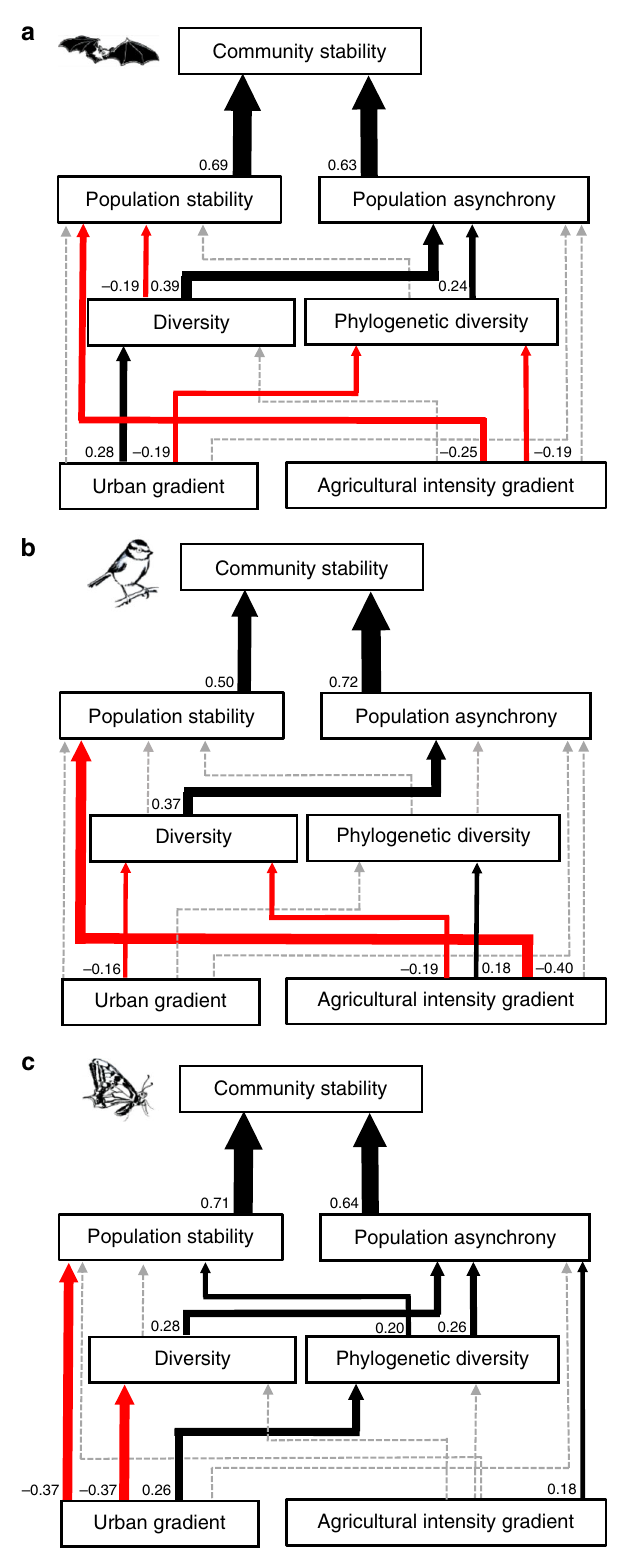
Fig. 4 Effects of habitat degradation and local diversity on community stability estimated by structural equation models. Panels refer to bat ( a ), bird ( b ), and butter fl y ( c ) communities. Urban gradient and agricultural intensity gradient are independent variables while species diversity, phylogenetic diversity, population stability, population asynchrony, and community stability are dependent variables. Black and red arrows represent positive and negative relationships, respectively, with relationship strength depicted by arrow width. Solid and gray dashed arrows represent signi fi cant relationships and nonsigni fi cant relationships, respectively (Supplementary Table 3, see “ Methods ” ). Standardized coef fi cients are shown next to the arrow